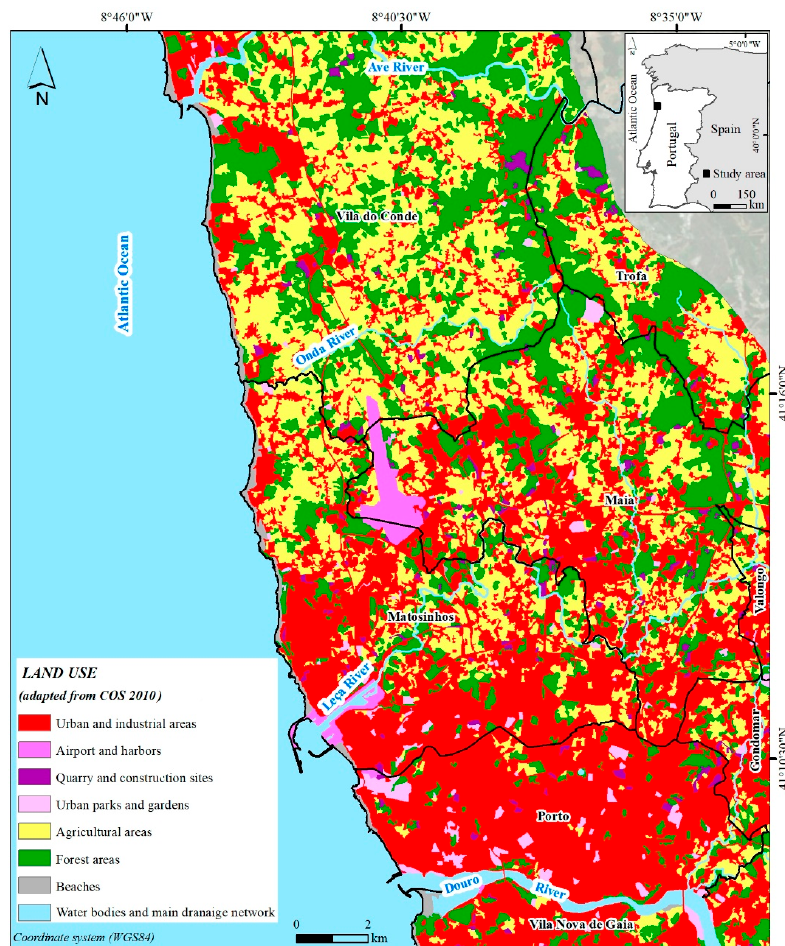
Figure 1. Land use of the urban coastal region between the Municipalities of Vila do Conde and Vila Nova de Gaia (adapted from [59]).